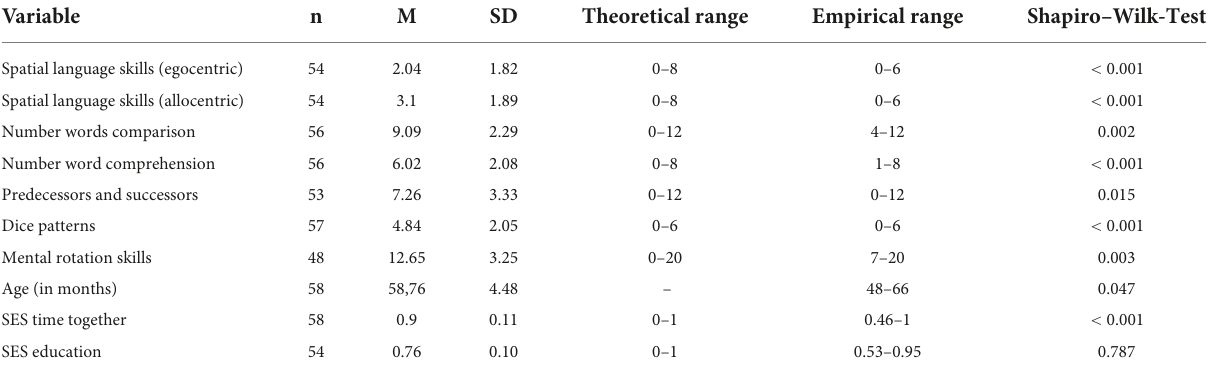
TABLE 1 Descriptive statistics for the variables assessed in